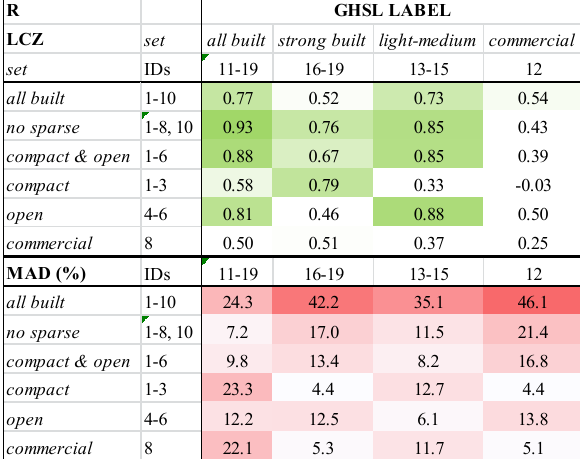
Accordance between aggregated built fractions on a 1000 m grid using different sets of LABEL (columns) and LCZ (rows) classes. Correlation